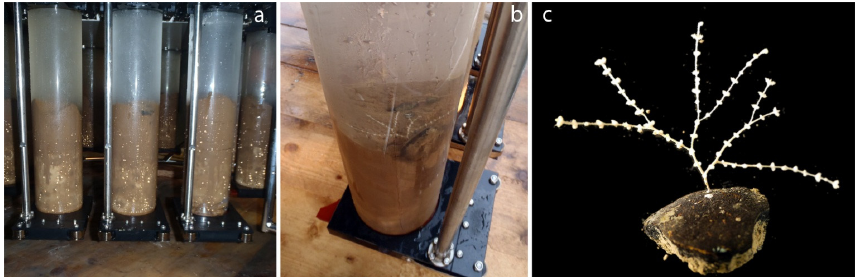
Figure 6. The multiple core (here a megacore type) is not normally a suitable sampling device for the CCZ as the macrofaunal abundances are too low. However, it can be used for opportunistic sampling from cores destined for other purposes—here a primnoid coral on a nodule has been sampled from a core destined for microbiology studies.